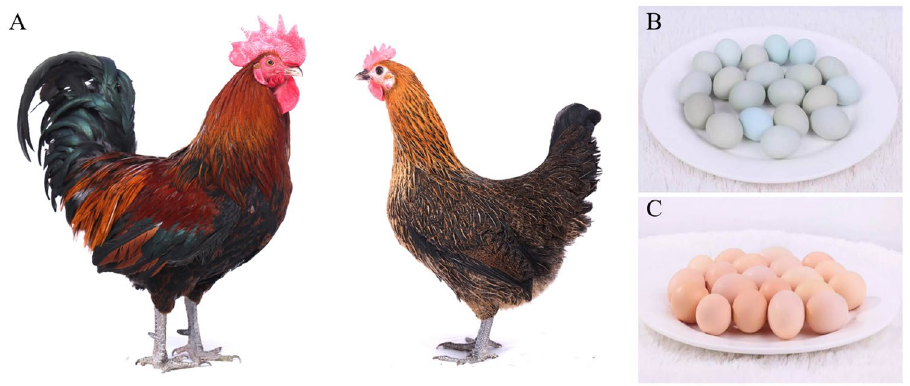
Figure 7. ( A ) Yimeng rooster (left) and hen (right). ( B ) The chicken with blue-green-shelled eggs can represent the presence of EAV-HP inserted mutation (IM+) in the 5 ′ region of SLCO1B3 . ( C ) The chicken with brown- shelled eggs can represent without EAV-HP insertion